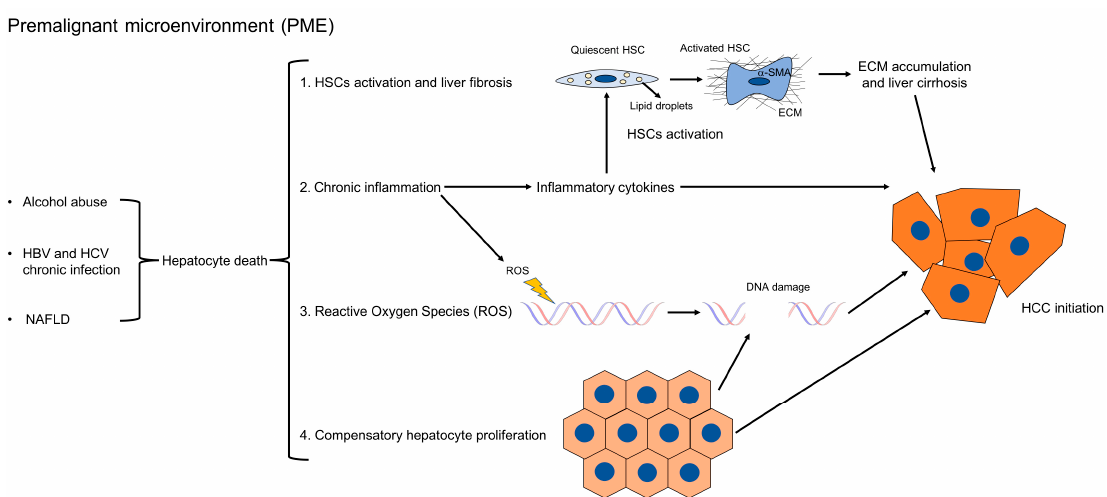
Figure 1. Mechanisms which promote HCC formation in PME. In PME, chronic liver injury causes hepatocyte death, which triggers inflammation, the activation of hepatic stellate cells into ECM-producing myofibroblasts, compensatory hepatocyte proliferation, the release of reactive oxygen species (ROS), and DNA damage. Continuous cycles of this destructive–regenerative process, which precedes tumor formation, are proposed to give rise to replication-related mutations in hepatocytes and eventually HCC. The links between the different mechanisms are indicated here.